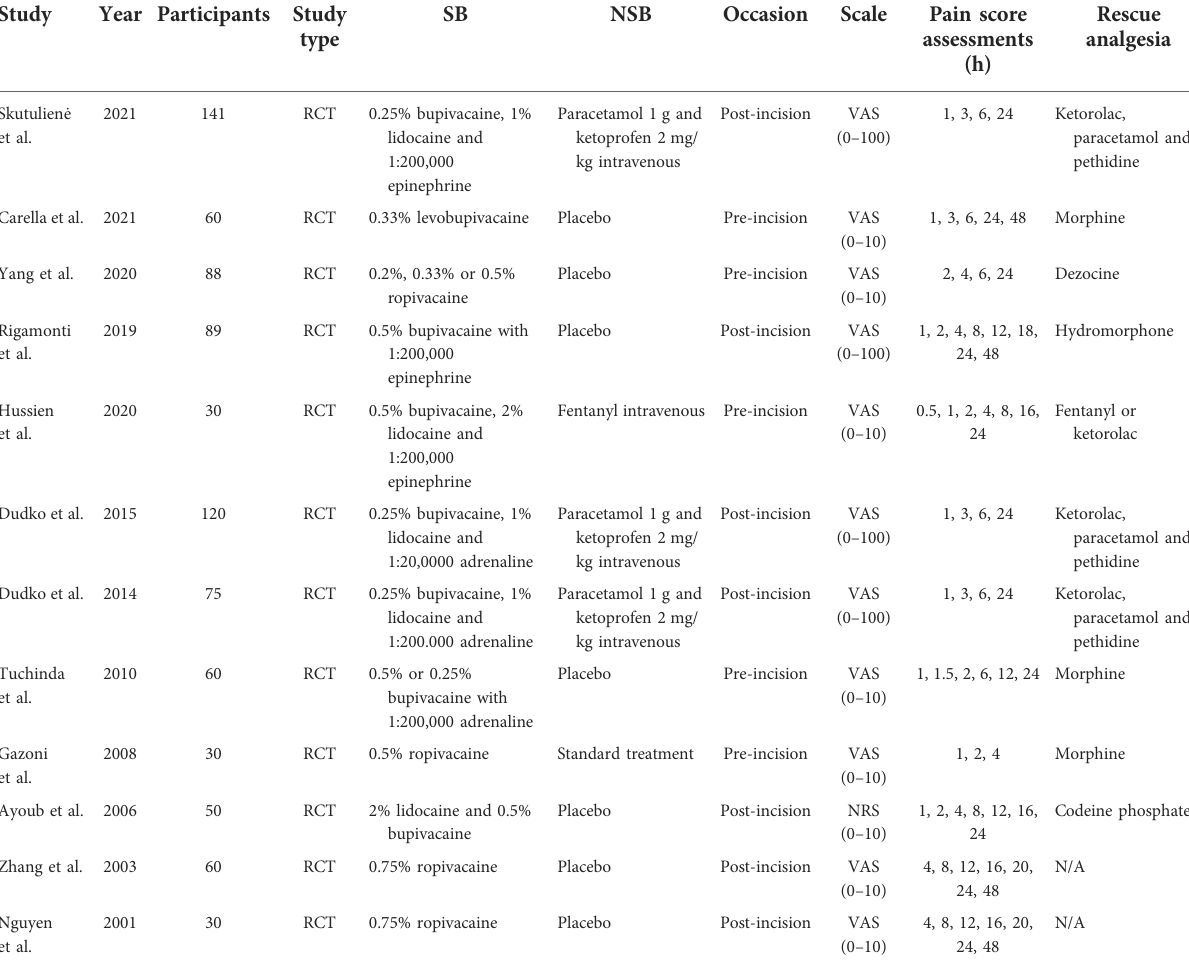
TABLE 1 Characteristics of included